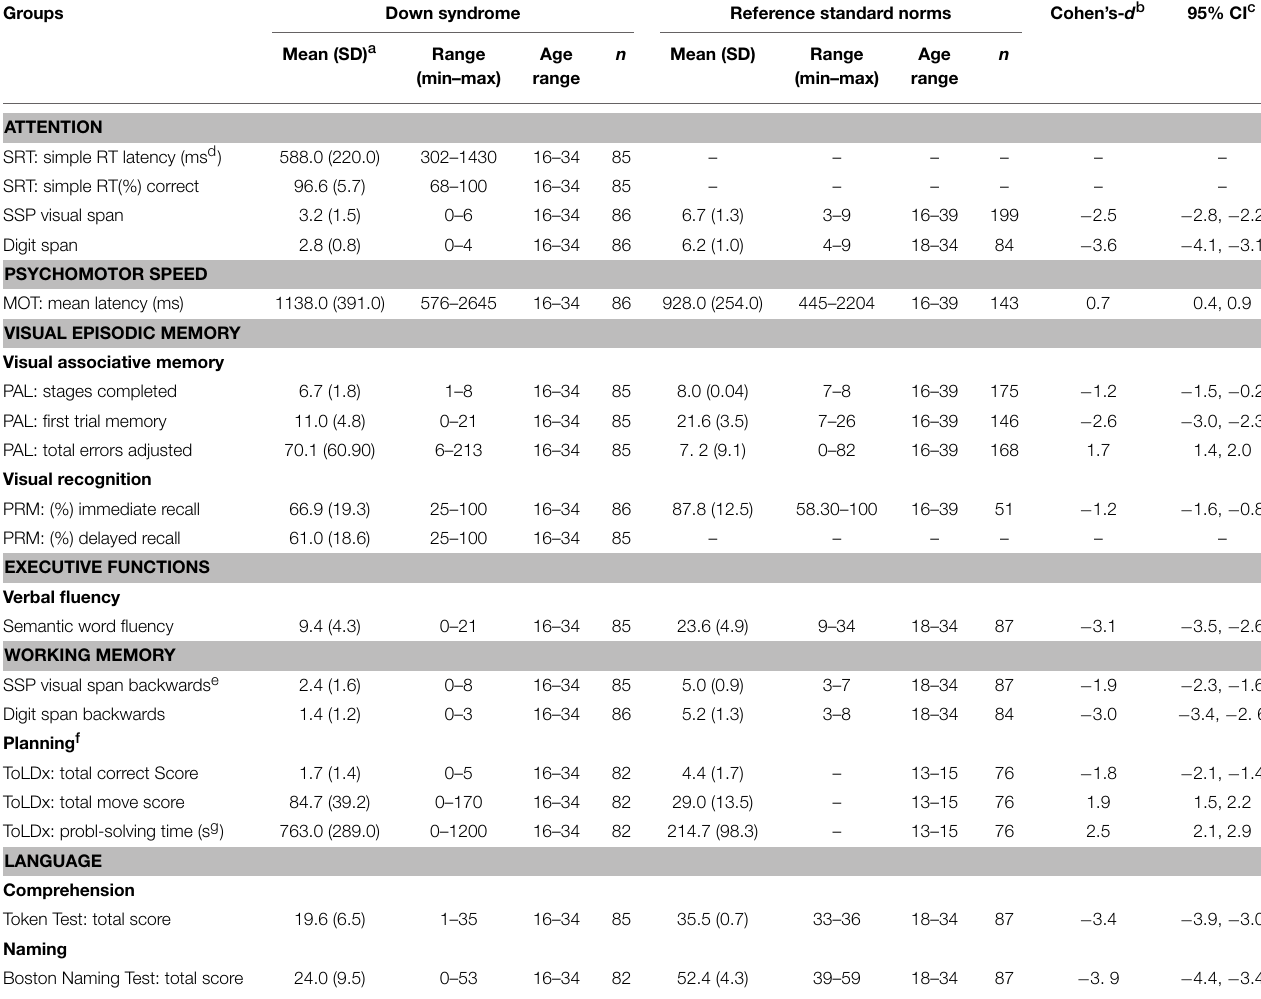
TABLE 2 | Cognitive performance in Down syndrome participants compared to standard norms.